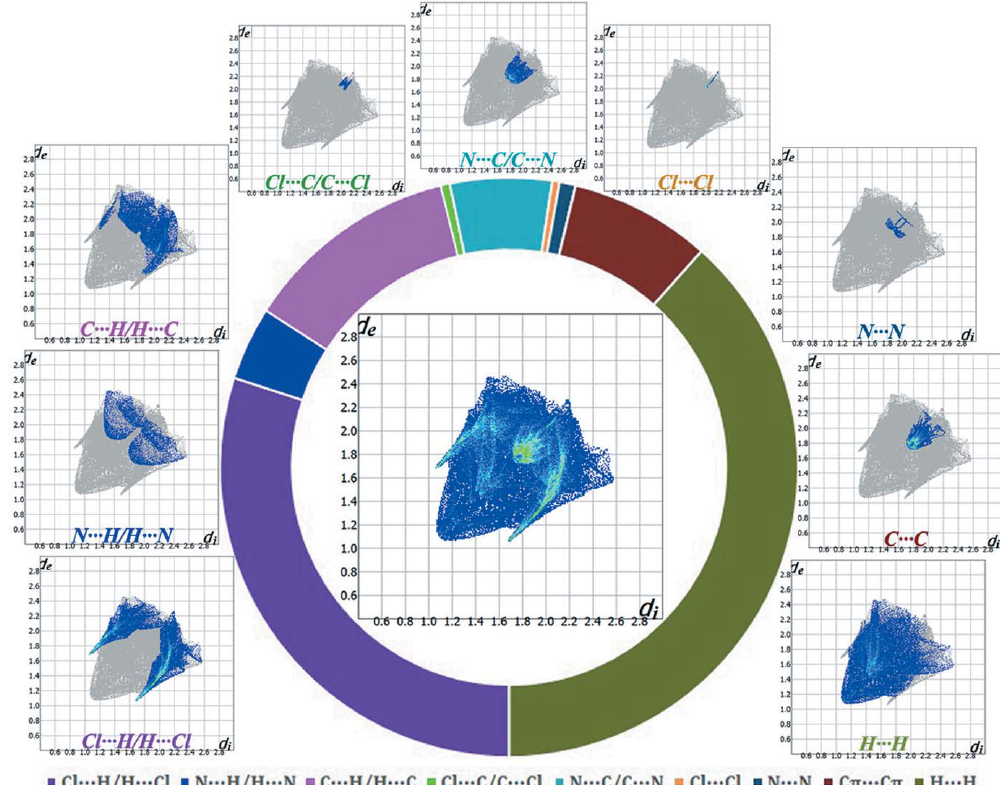
Figure 5 Fingerprint plots: full (middle) and decomposed plots corresponding to all contacts involved in the structure [clockwise: from bottom left to bottom right]. The relative contributions of various intermolecular contacts to the Hirshfeld surface area of the title structure are displayed by the schematic illustration.